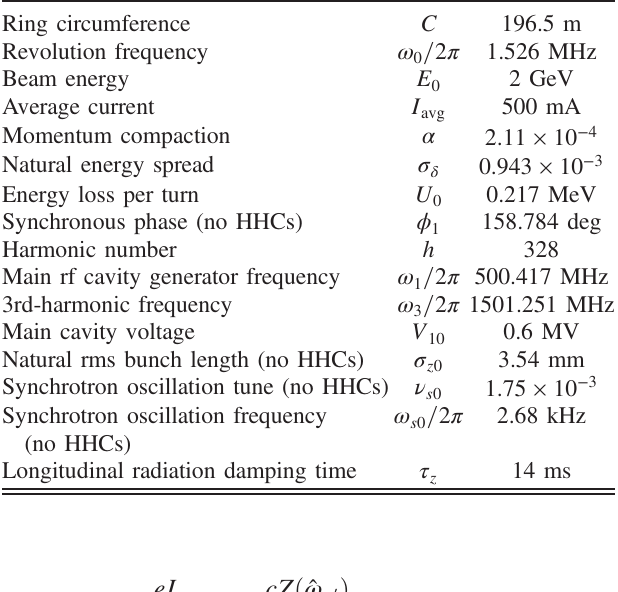
TABLE I. ALS-U v20r lattice parameters.